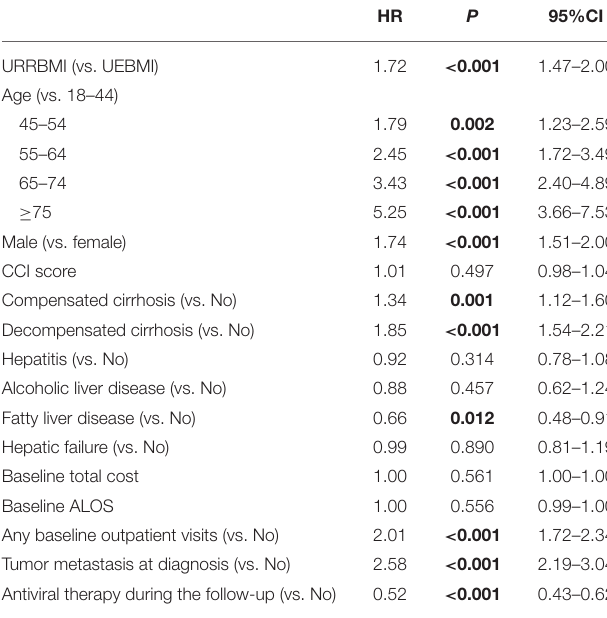
TABLE 3 | Multivariate analysis for overall survival in patients with TABLE 2 | Patients’ overall survival during the follow-up period. Overall UEBMI URRBMI